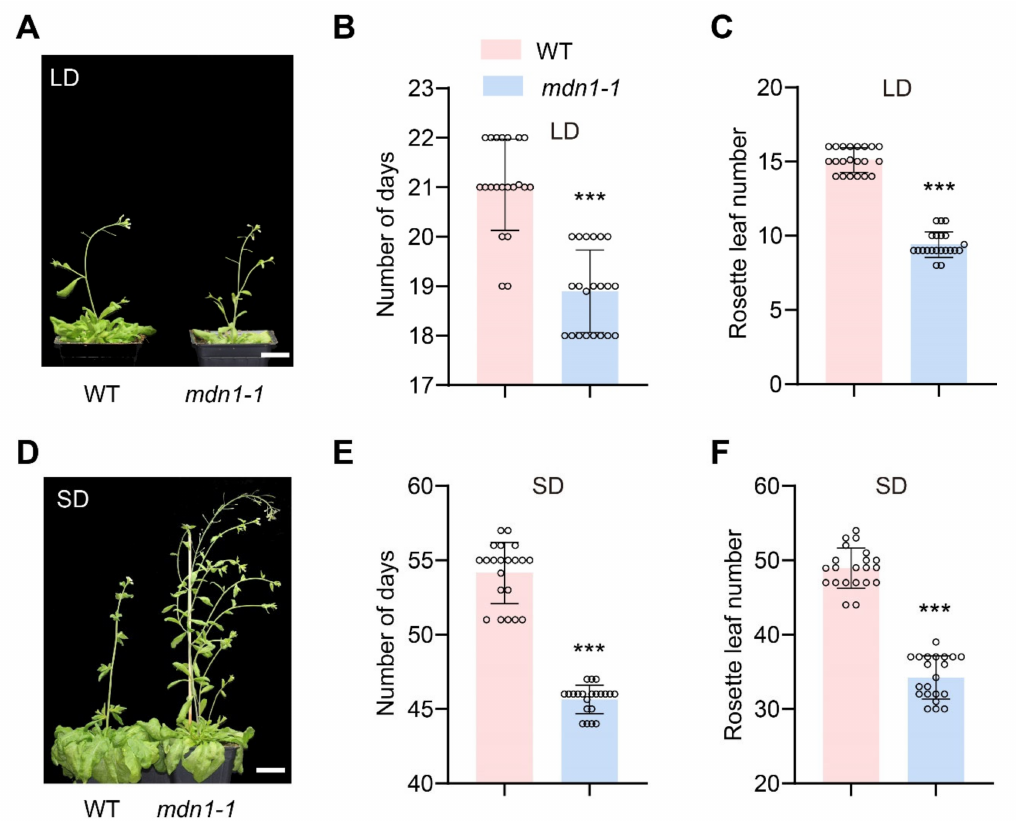
Figure 1. Mutation in MDN1 leads to early flowering. ( A )Wild-type (WT) and mdn1-1 plants grown in long days (LD). ( B , C ) The number of days and rosette leaf number at flowering grown in LD. Twenty plants (grown in LD) were scored. ( D ) WT and mdn1-1 plants grown in short days (SD). ( E , F ) The number of days and rosette leaf number at flowering grown in SD. Twenty plants (grown in SD) were scored. ( *** p < 0.001, Student’s t -test). Scale bars, 2